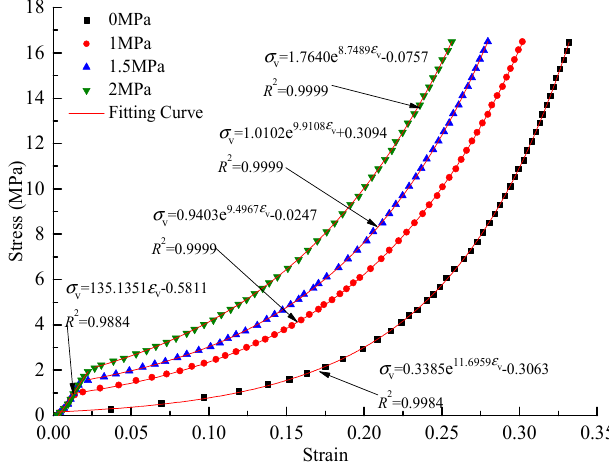
Figure 6. Stress-strain curves for backfill materials.